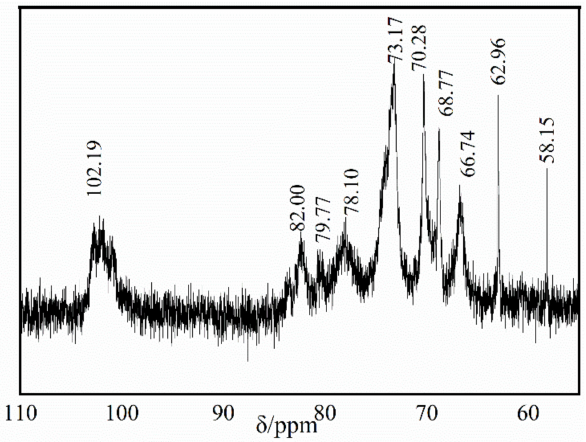
Figure 3. 13 C-NMR spectra of